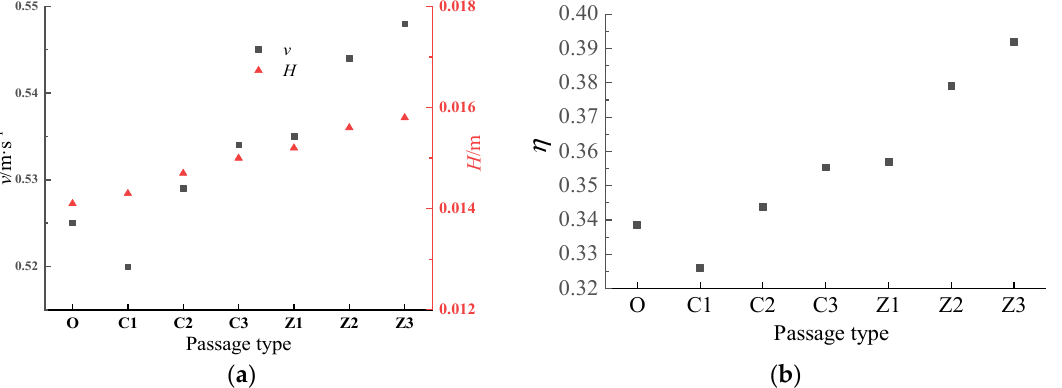
Figure 13. Comparison of hydrodynamic performance of different passage structures: ( a ) Type-velocity and head curve comparison; ( b ) Type-efficiency curve comparison.